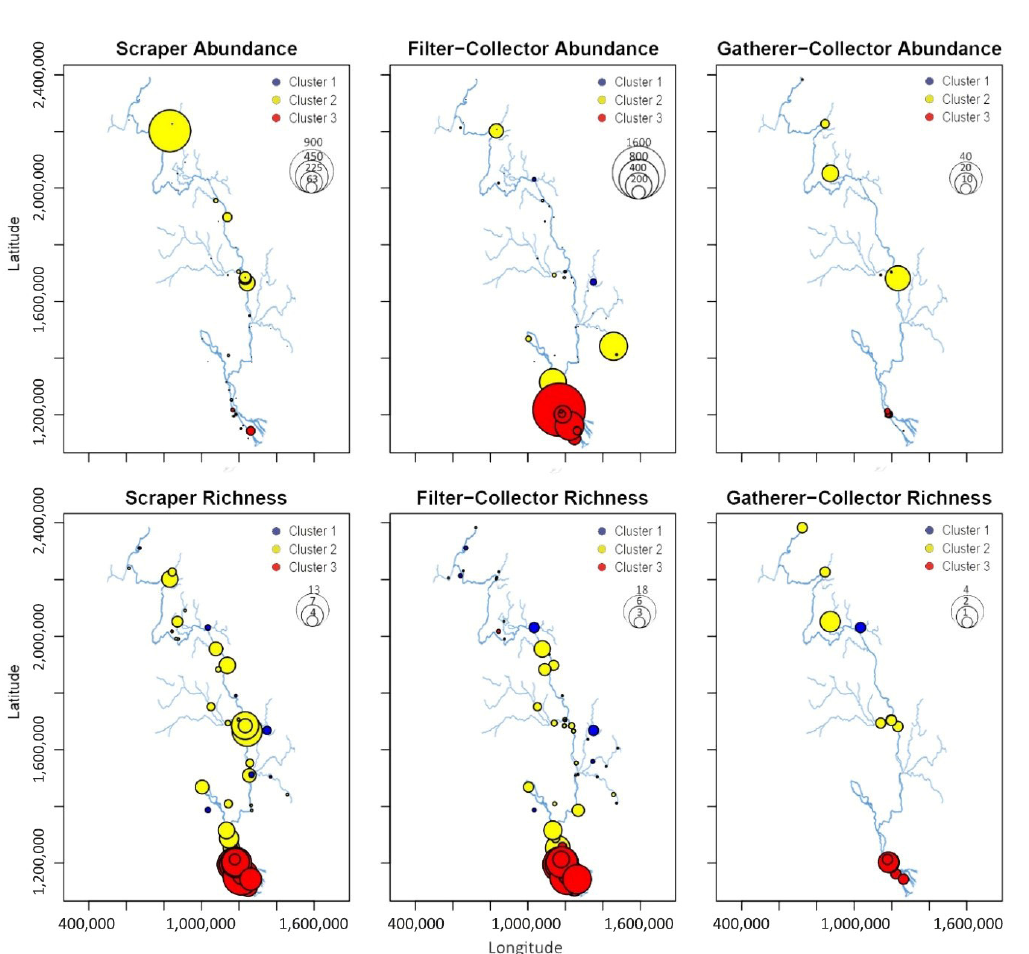
Figure 4. Abundance and richness distribution of mollusc functional feeding group communities in the Lower Mekong Basin.